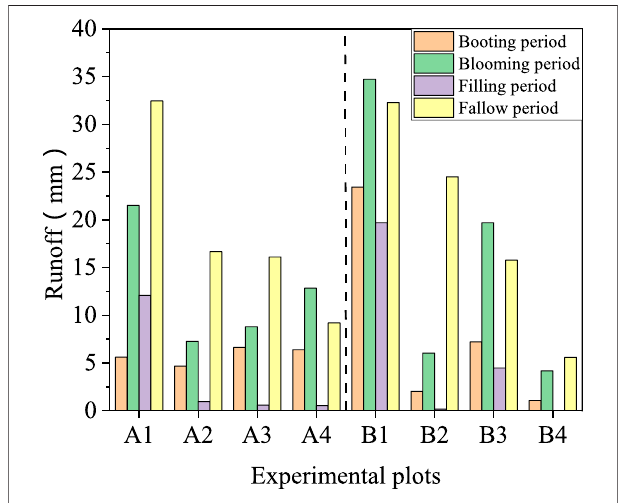
FIGURE 5 | Observed runoff in different plots and growth periods under 100 mm h − 1 (left) and 50 mm h − 1 (right) rainfall intensities. A1, A2, A3, and A4 aretheexperimentalplotsunder100 mm h − 1 rainfallintensity;B1,B2,B3,and B4 are the experimental plots under 50 mm h − 1 rainfall